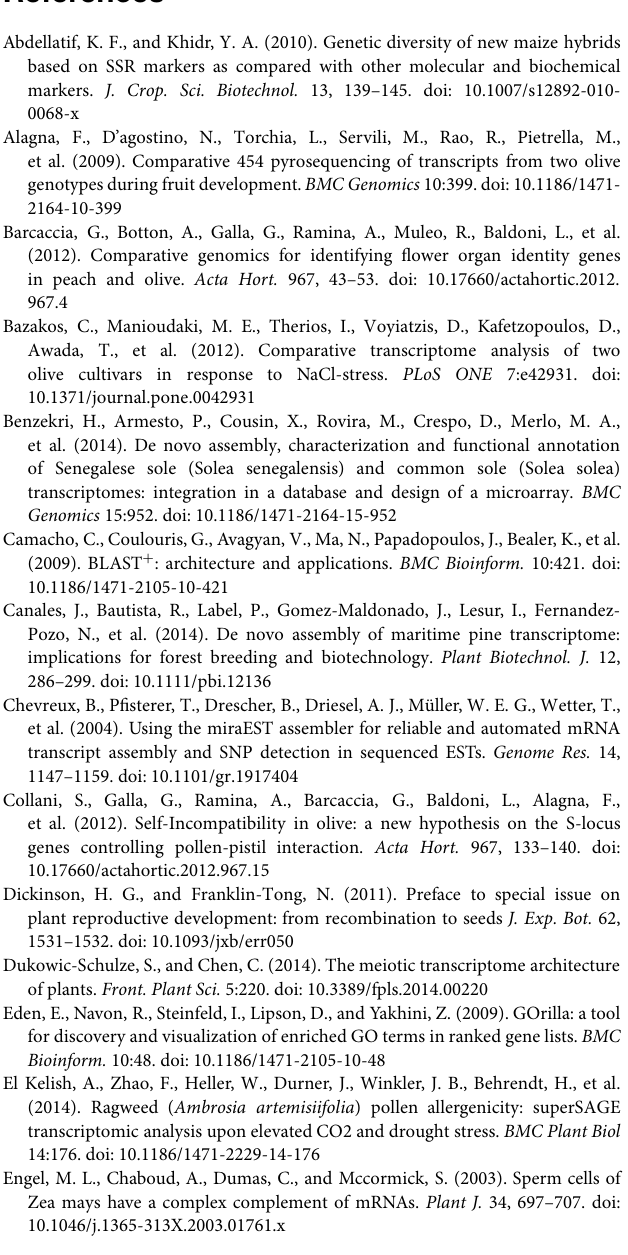
yellow, double-lined boxes are the inputs, and the black boxes provide the output results. Figure S2 | The flow template based on AutoFlow that automates the complete process from pre processing to annotation. Execution AutoFlow with the parameter –graphic with this flow template produces its semantic representation as in Supplementary Figure S1 . Figure S3 | GO enrichment using GOrilla of the 1655 TTs that are pollen-specific, sorted by their RPKM, that have an Arabidopsis orthologue in RefSeq. The upper part contains the significant biological processes and the lower part reveals the cellular component where the processes